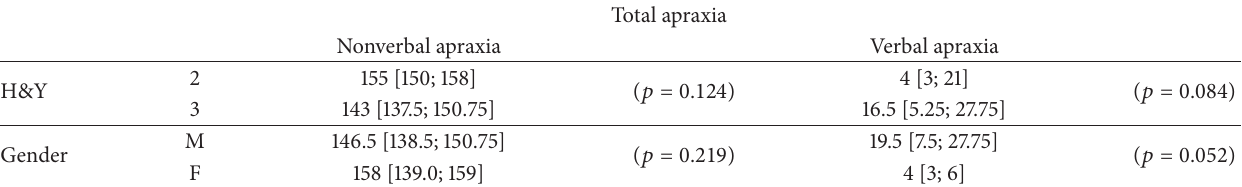
Table 4: Comparison of PD stages (H&Y) and gender between patients with verbal and nonverbal apraxia.